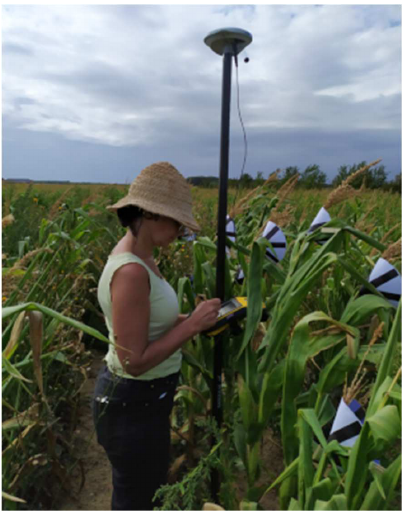
Figure 11. Position of the 70 marked plants recorded with the Geo7x receiver in pole mode.